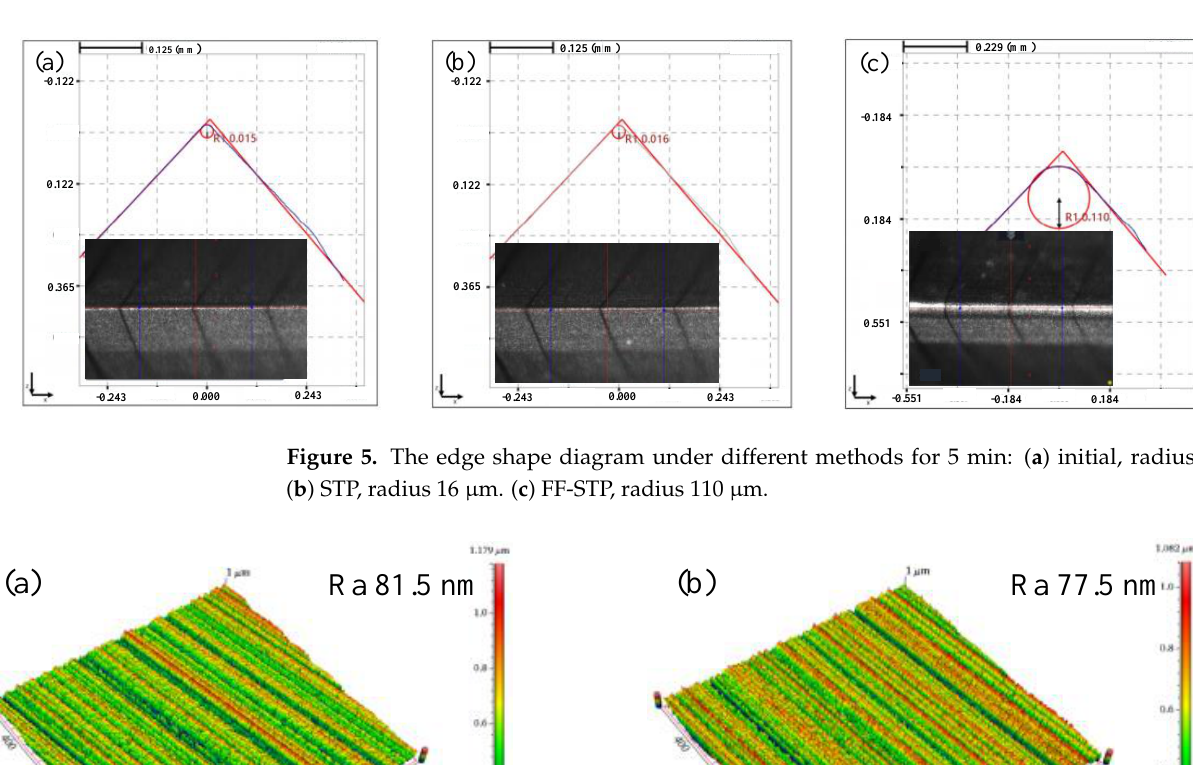
Figure 6. Topography of flank face: ( a ) STP. ( b ) FF-STP.